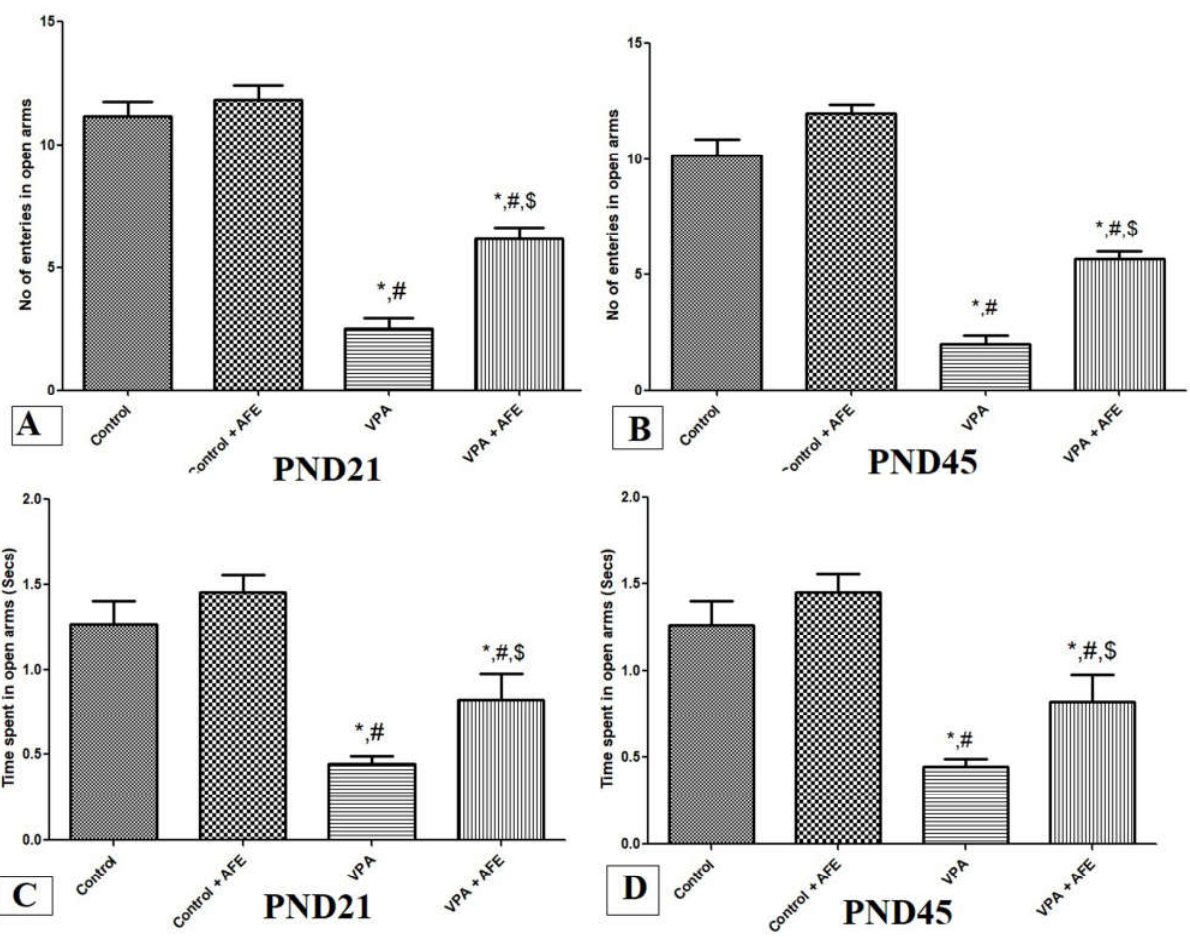
Figure 2. Effect of AFE on anxiety evaluated by using the elevated plus- maze. The effect of AFE on the number of entries on open arms at PND21 ( A ) and PND 45 ( B ) and the effect of AFE on time spent (secs) in open arms at PND21 ( C ) and PND45 ( D ). Data are expressed as mean ± SEM. * significant vs. control group, # significant vs. control + AFE group, $ significant vs. VPA group. p ≤ 0.05 is considered